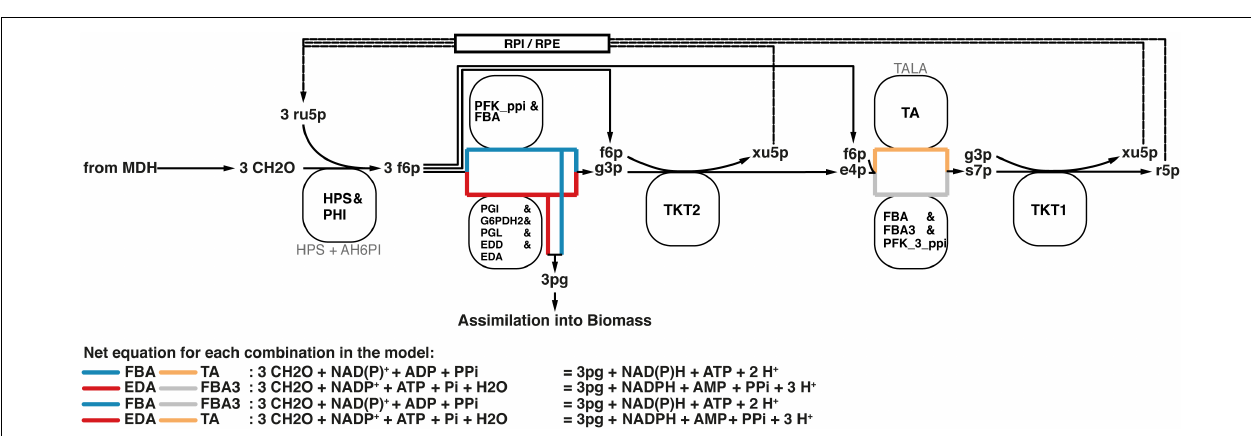
FIGURE 4 | All four variants of the RuMP pathway are represented in the metabolic model. If there is a common enzyme name the black text denotes the common name, while faint gray text denotes the reaction ID in the metabolic model. Otherwise the black text is also the reaction ID in the